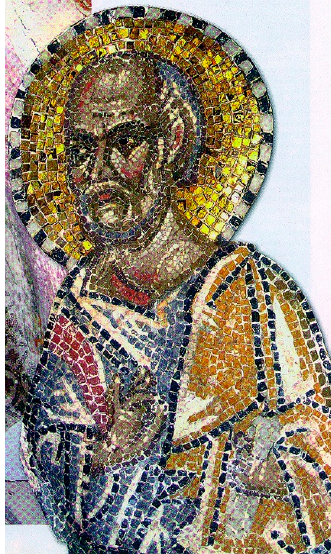
Figure 10. Pera, the church of St. Paul, north chapel (perhaps of St. Nicholas and of the Perso family), the upper part of the east wall, detail of the mosaic, St. Peter ? (mid-14th century?), after Rönesans (2012, p. 41).